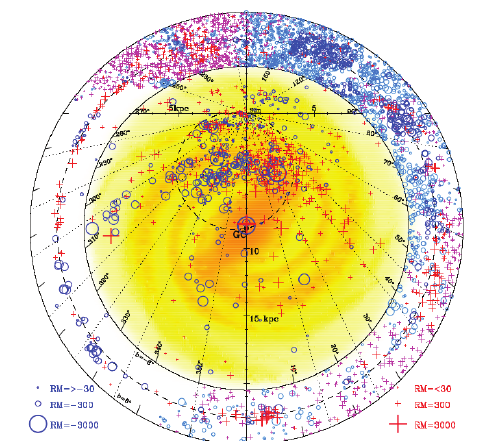
Figure 5. Top view of the Galactic disk showing the RMs of low- latitude ( | b | < 8 ◦ ) radio sources: Galactic pulsars observed with the Parkes 64m and Green-Bank 100m radio telescopes (in the inner disk) and extragalactic point sources from the literature (in the outer ring) [25]. Positive (negative) RMs, wich correspond to a magnetic field pointing on average toward (away from) the observer, are plotted in red (blue). The symbol size is propor- tional to | RM | 0 . 5 . The background yellow pattern is an artist’s impression of the Galactic